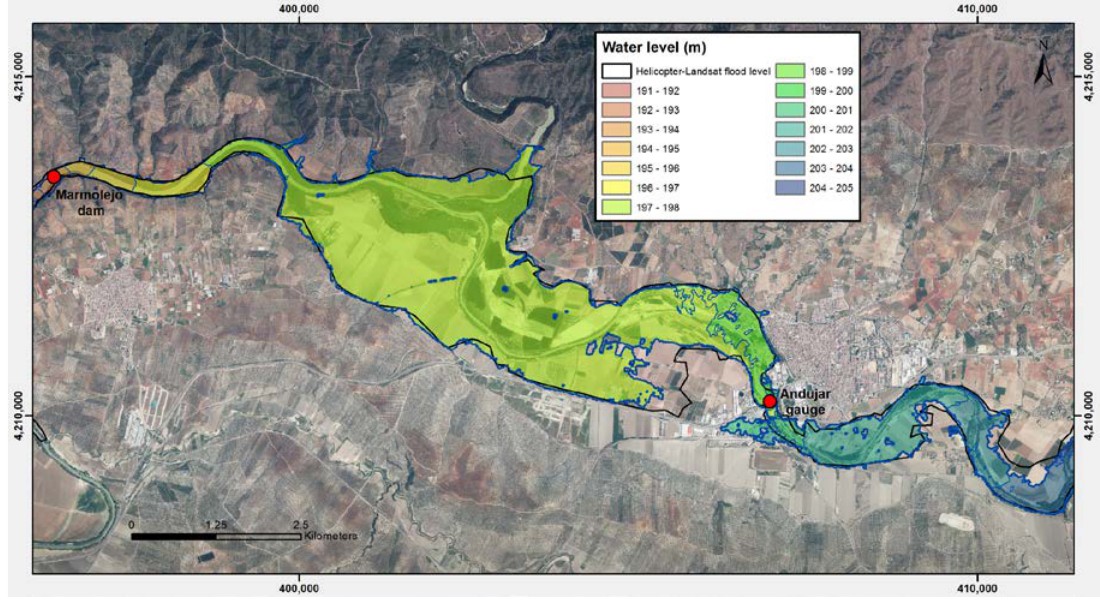
Figure 9. Numerical flood simulation (coloured transparent contour) and flooded area derived based on Landsat/TerraSAR-X/helicopter data (solid line in black) on 24 February 2010. The location of Marmolejo dam and the stream gauge near Andújar city is also given. Flow from right to left.